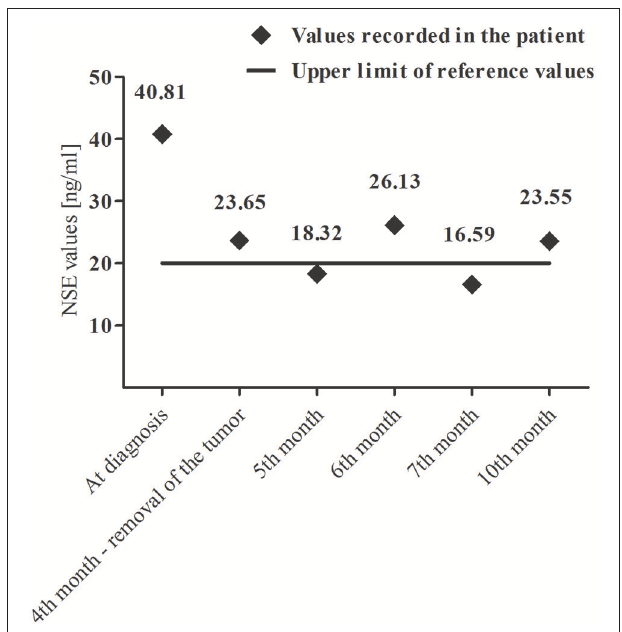
FIGURE 2 | Variability of neuron-specific enolase (NSE) levels during and after combined-modality therapy.